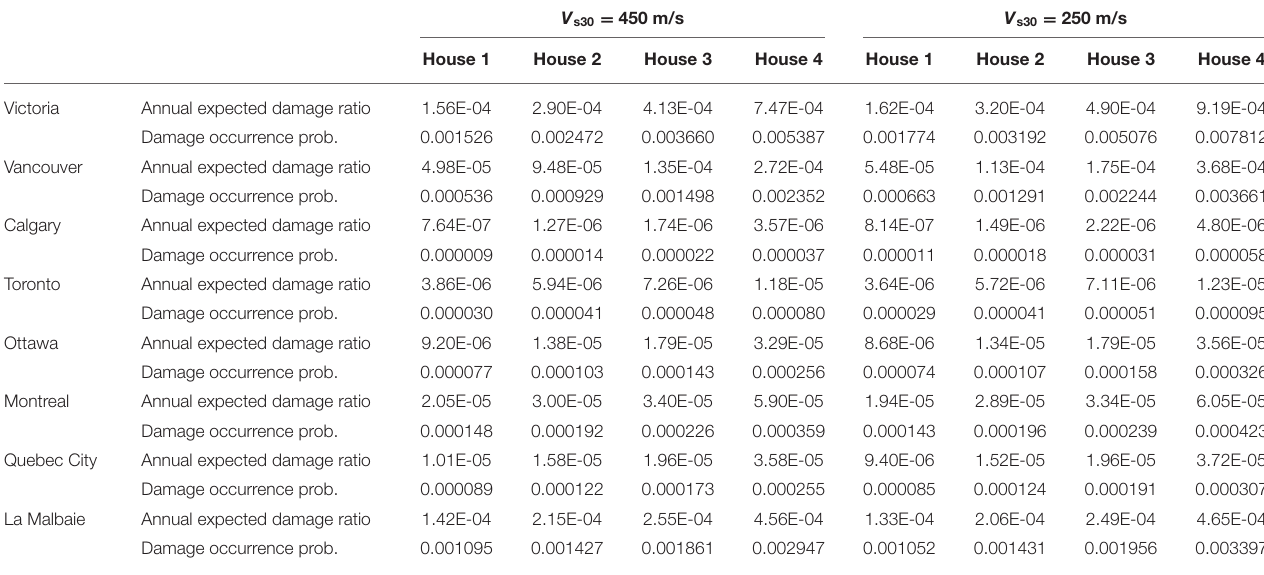
TABLE 1 | Annual expected damage ratio and damage occurrence probability for the four house models located at two site conditions corresponding to V s30 = 450 m/s and V s30 = 250